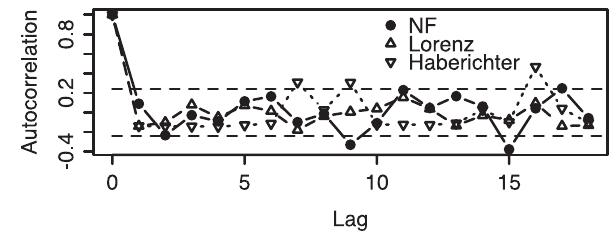
Figure 6. Autocorrelation of cycle times for a Nod Factor time series and two positive controls based on chaotic mathemat- ical models. The X axis is the lag measured in number of samples (sample time is 5 seconds). All time series show a rapid drop to within the 95% confidence interval for white noise which is marked with horizontal dashed lines and represents no identifiably repeating patterns.